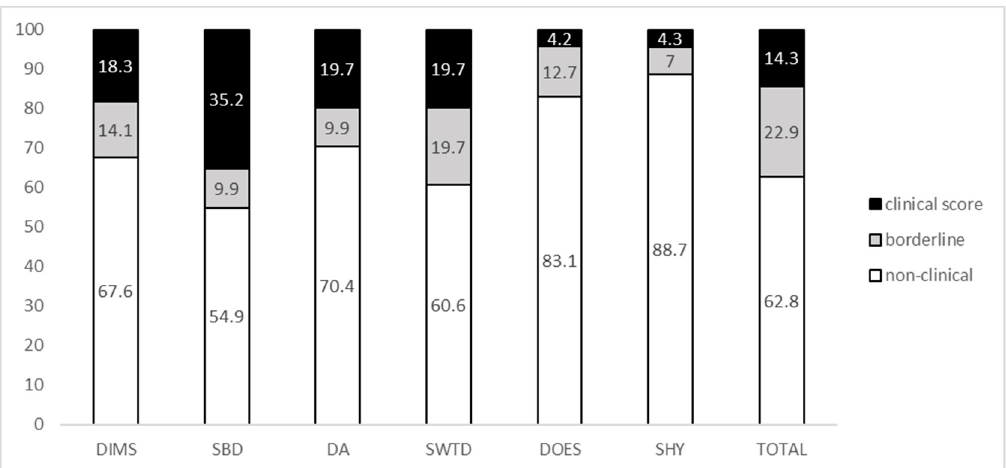
Figure 1. Distribution of sleep disturbances in children and adolescents with DS (percentage). DIMS: disorders in initiating and maintaining sleep; SBD: sleep breathing disorders, DA: disorders of arousal, SWTD: sleep–wake transition disorders, DOES: disorders of excessive somnolence; SHY: sleep hyperhidrosis.